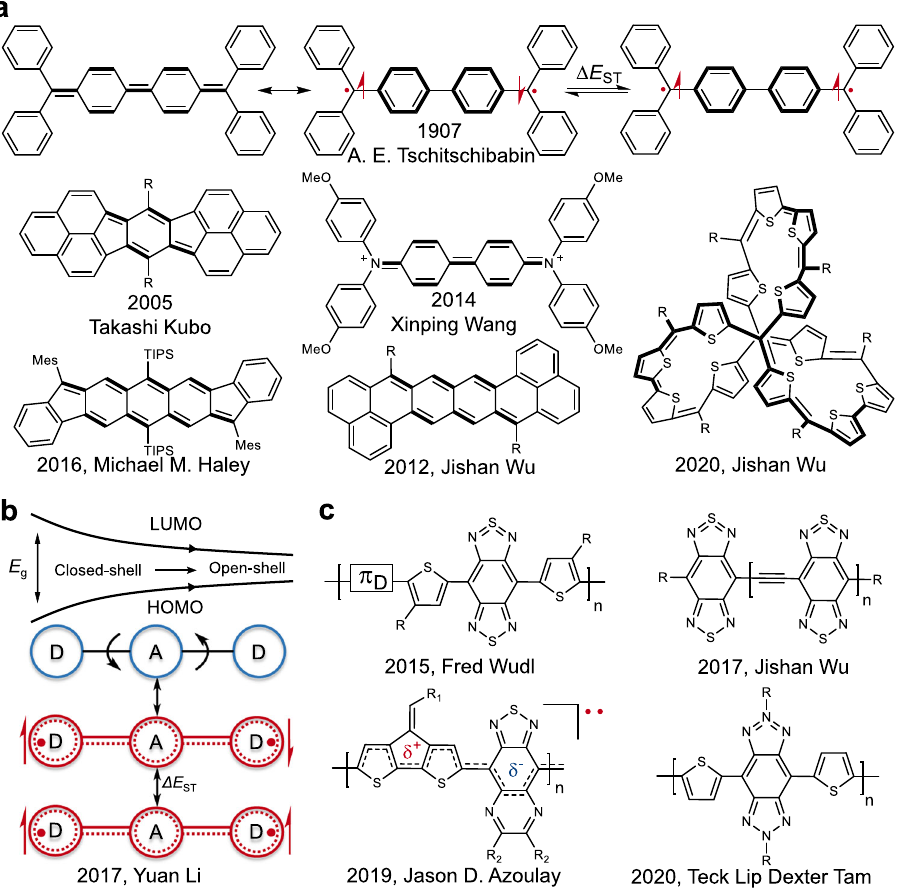
Fig. 1 Molecules and polymers with open-shell ground states. a Electronic structure of open-shell Kekulé-type Tschitschibabin ’ s hydrocarbon with the resonance structure between the closed- and open-shell structures as well as the thermally excited triplet state 19 . Examples of typical compounds with a similar mechanism drawn in closed-shell resonance form 23,26 – 29 . b The widespread cross-over from closed- to open-shell character through narrowing of the bandgap of the donor-acceptor molecules initially reported in our previous work 31 . c Examples of donor-acceptor small molecules and polymers containing benzo[1,2- c ;4,5- c ]bis[1,2,5]thiadiazole and other similar acceptor units with open-shell character 32 – 36